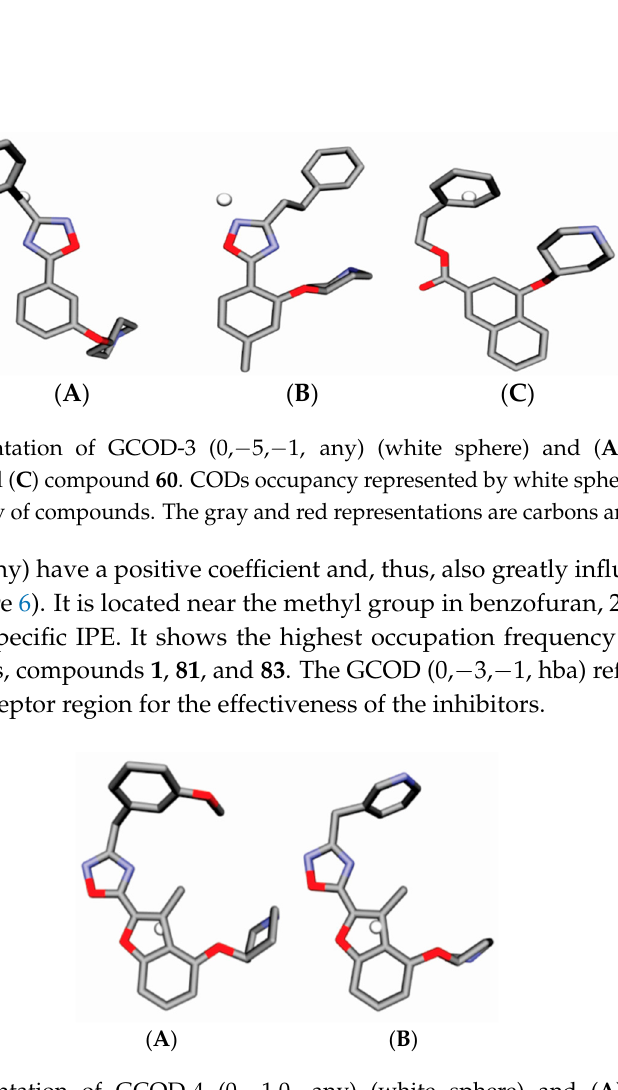
Figure 6. Representation of GCOD-4 (0, − 1,0, any) (white sphere) and ( A ) compound 81 , and ( B ) compound 83 . CODs occupancy represented by white spheres contributes to increasing the potency of compounds, and the gray and red representations are carbons and oxygen atoms.